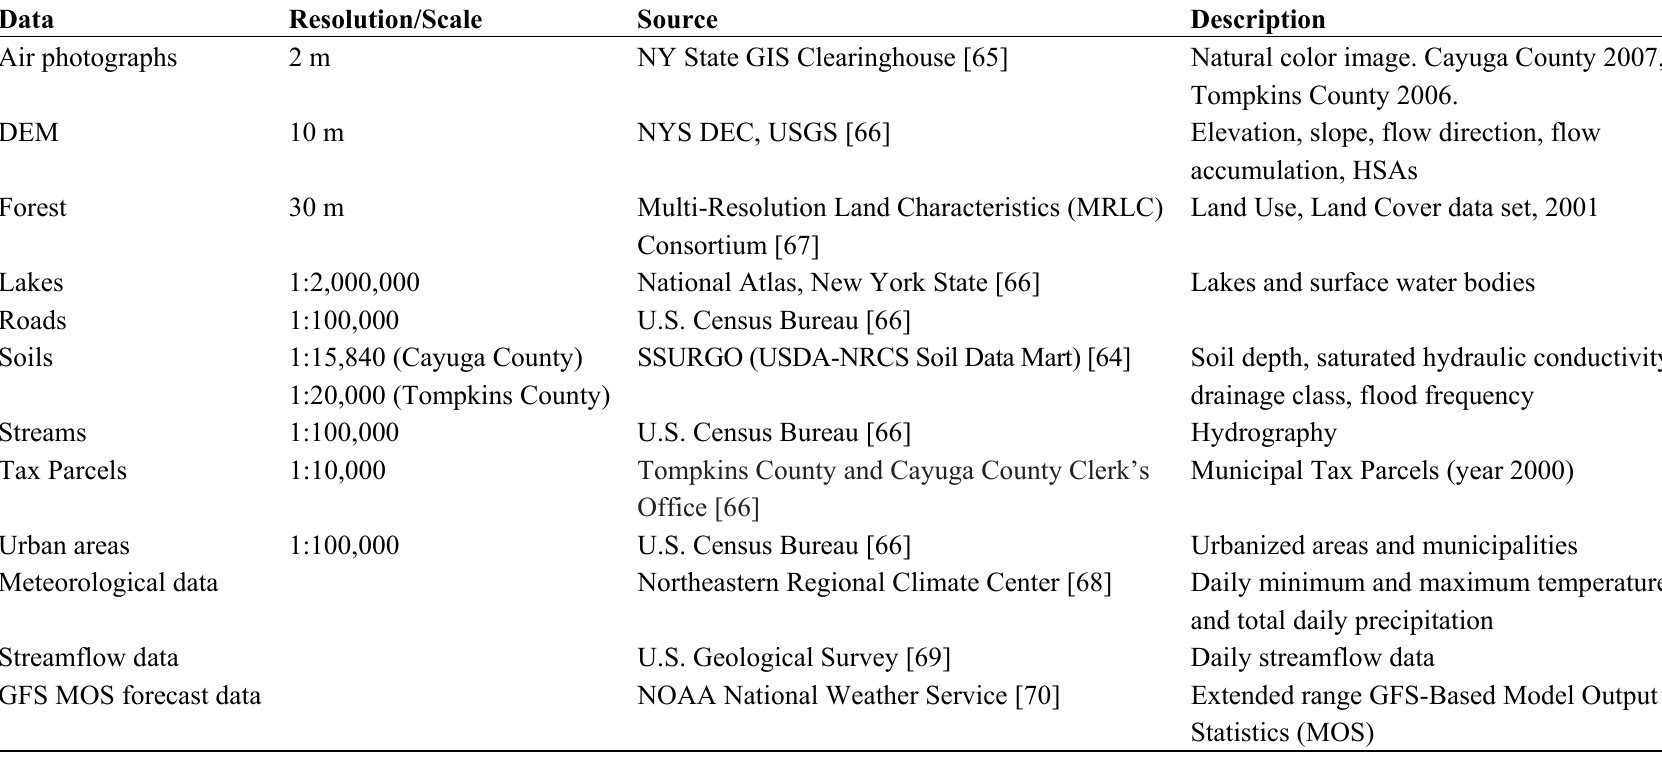
Table 2. Multisource geospatial and hydro-meteorological database developed for the HSA prediction